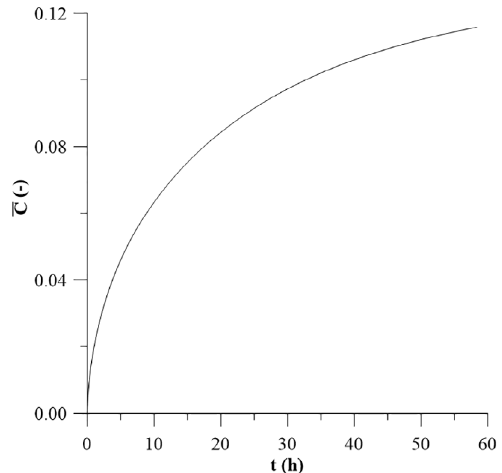
Figure 5. Kinetics of average free water concentration in the composite.